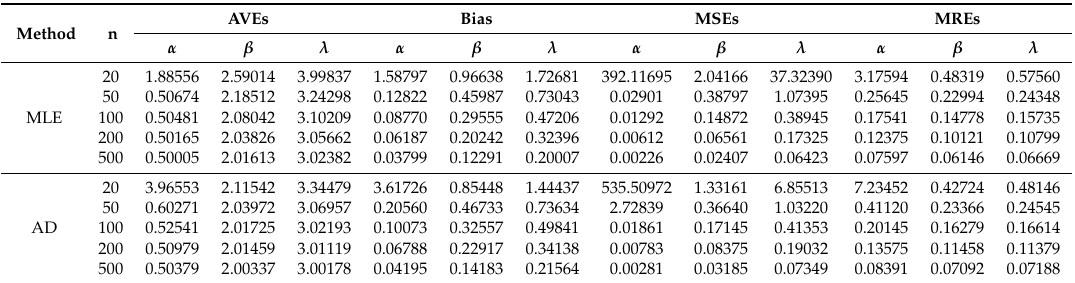
Table 5. Simulation values of the AVEs, biases, MSEs, and MREs for ( α = 0.5, β = 2, λ = 3 )